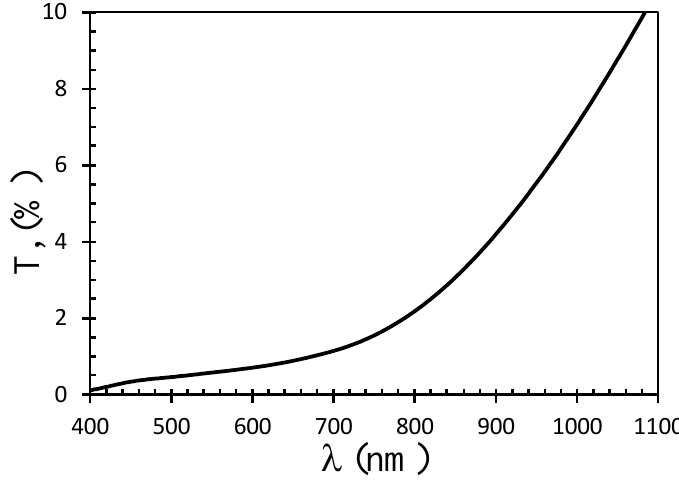
Figure 4: Transmittance spectrum of the FeS 2 at substrate temperature 200 o